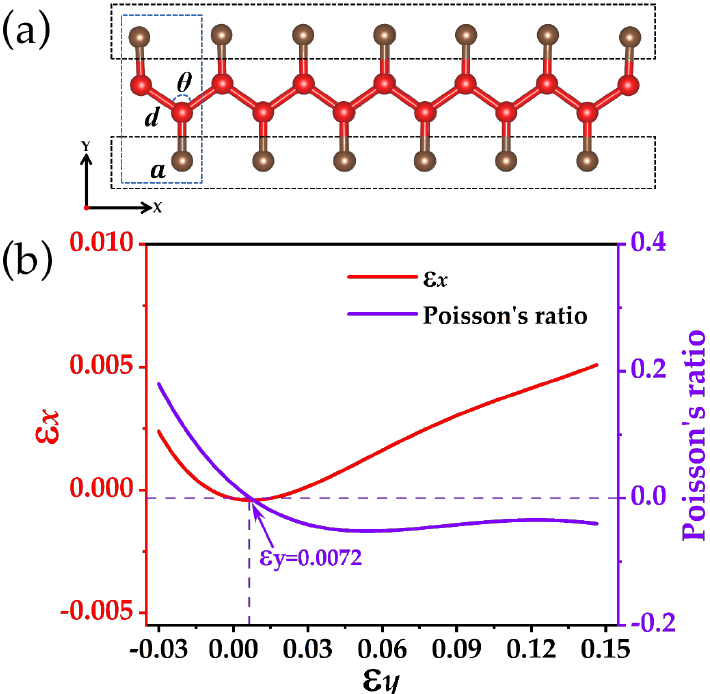
Figure 1. The schematic structure of the optimized zigzag carbon chain in ( a ) and the mechanical response under the uniaxial strain along y -axis in ( b ). The bond angle and the bond length are marked by 𝑑 and 𝜃 . The fixed carbon atoms are represented by the brown balls and the red balls are free-moving carbon atoms. 𝜀 𝑦 is the strain along the y -axis, and 𝜀 𝑥 is the response of the driven strain in the x -axis. The red line indicates the 𝜀 𝑥 − 𝜀 𝑦 curve under the uniaxial strain along the y direction, and the purple line represents Poisson’s ratio under the uniaxial strain along the y -axis. The purple dotted line represents zero Poisson’s ratio.